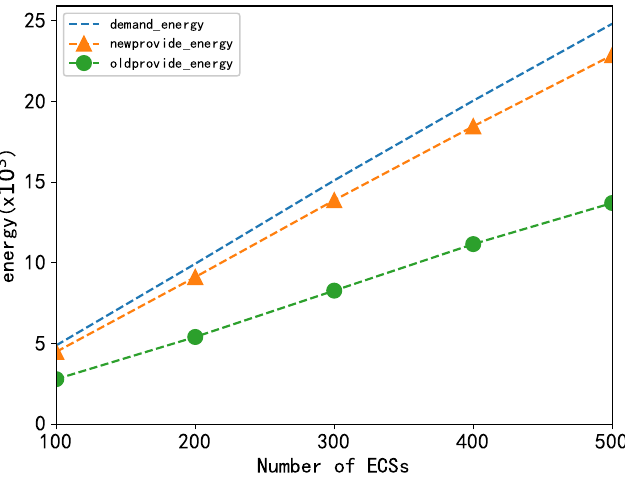
Figure 5. Differences in energy supply and demand under different incentive